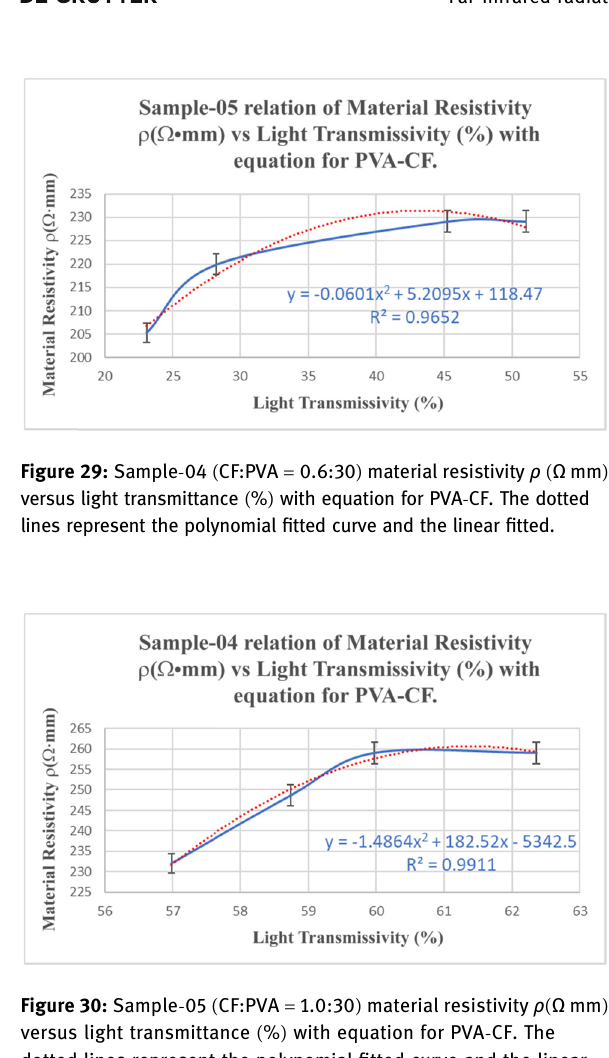
Table 5: Sample design calculations for Sample - 03 CF:PVA = 0.3:30 ( 1% ) at TH = 0.8 mm